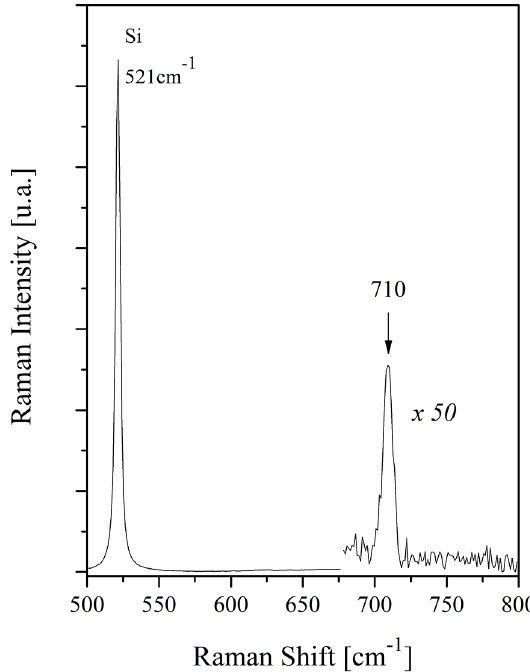
appreciation. This has been attributed to the longitudinal optical phonon of the GaN in wurtzite structure, A Some authors previously reported on Raman mode shifts in GaN with a frequency lower than 734 cm -1 , the shift